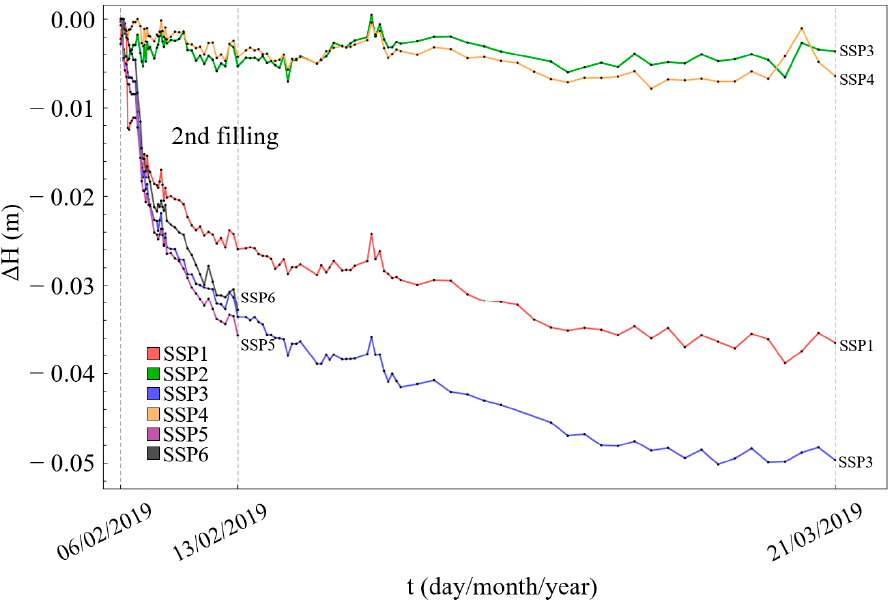
Figure 10. Settlement visualization of points SSP1 to SSP6, from 06 / 02 / 2019 to 21 / 03 / 2019 (13 / 02 / 2018). Settlement data of points MG1 to MG19, obtained during the second filling of the reservoir, were used in the analysis to determine the appropriate model and approach for future monitoring adjustments. Table 3. Height values of points MG19 to MG21, points DRMG19a and DRMG20a, and points SSP1 to SSP6, relating to the start and end time of monitoring.